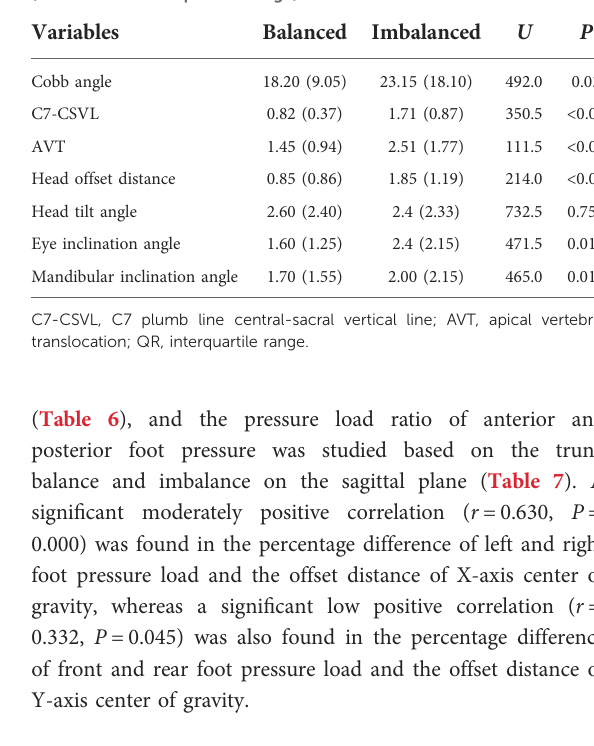
TABLE 1 Trunk coronal imbalance in patients with different degrees and types of scoliosis. Variables Imbalanced